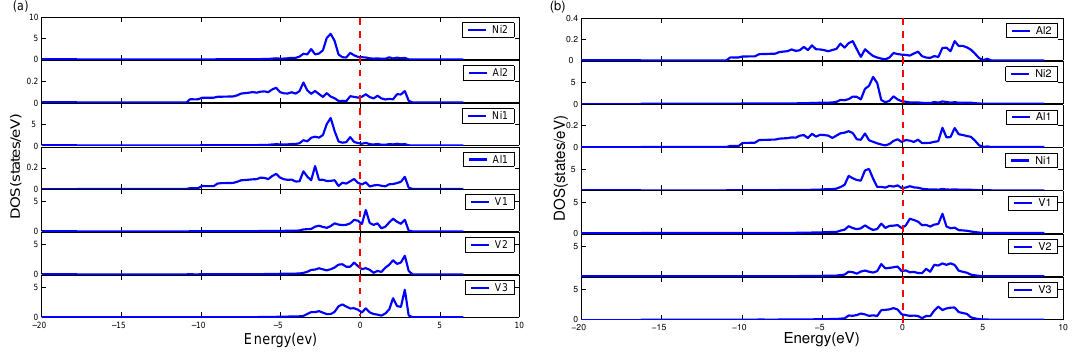
Figure 4. Layer-Projected Density of States (LPDOS) for ( a ) NiAlV and ( b ) AlNiV interfaces. The vertical dotted line gives the location of the Fermi